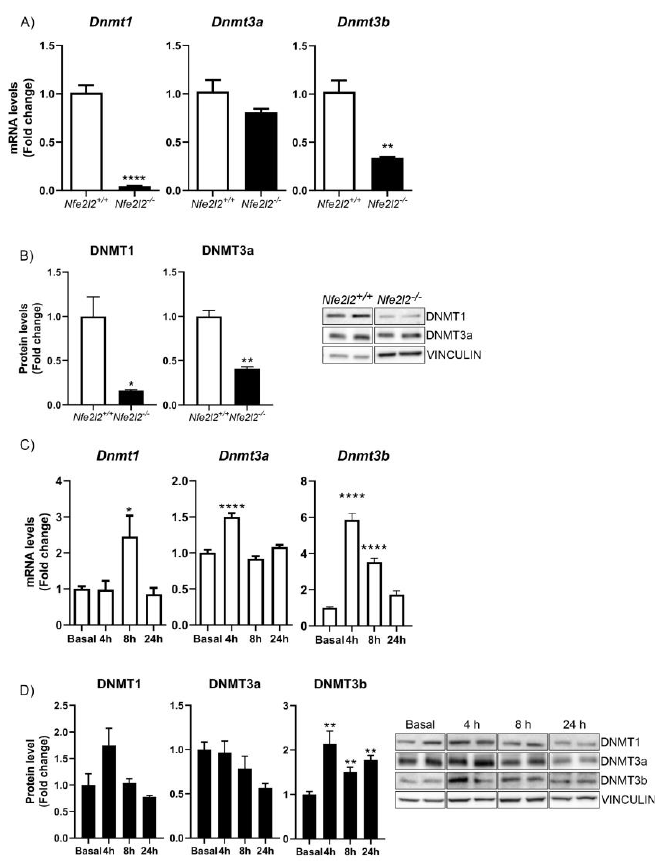
Figure 2. NRF2 promotes the expression of DNMT1 and DNMT3b . ( A ) qPCR measurement of the levels of Dnmt1 , Dnmt3a , and Dnmt3b mRNAs in Nfe2l2 +/+ and Nfe2l2 −/− MEFs. n = 3 − 4 samples ± SEM. ( B ) The protein levels of DNMT1, DNMT3a, and DNMT3b were analyzed via immunoblotting and quantification based on densitometry using the same samples as in ( A ). n = 3 − 4 samples per experimental group ± SEM. Asterisks denote significant differences: * p < 0.05, ** p < 0.01, and **** p < 0.0001, comparing the indicated group with the wild-type mice according to a Student’s t- test. Time-course analysis of treatment of hippocampal HT22 cells with DMF (20 µ M). ( C ) RT-qPCR analysis of the levels of Dnmt1 , Dnmt3a , and Dnmt3b mRNAs. n = 4 − 5 samples ± SEM. ( D ) Protein levels of DNMT1, DNMT3a, and DNMT3b were analyzed via immunoblotting and respective quantification based on densitometry. n = 3 − 4 samples per experimental group ± SEM. The one-way ANOVA test with a Newman–Keuls posterior test was used to evaluate differences in significance between groups: ** p < 0.01 compared to basal